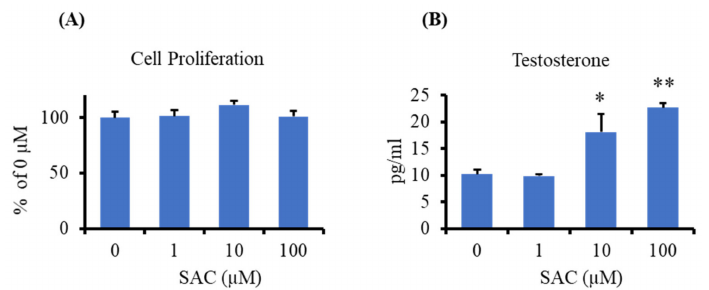
Figure 4. SAC enhances testosterone production in I-10 cells. ( A ) Cells at a density of 3.6 × 10 4 cells/well were incubated in 96-well plates for 24 h with different concentrations of SAC (0, 1, 10, and 100 µ M). Cell proliferation was determined by the water-soluble tetrazolium salts-1 (WST-1) assay. Data are presented as the mean ± SE ( n = 4–5). Data were analyzed by one-way ANOVA. ( B ) Cells at a density of 6 × 10 4 cells/well were incubated in 12-well plates with SAC for 24 h. Testosterone was measured from the medium by the EIA method. Data are presented as the mean ± SE ( n = 3). Data were analyzed by Dunnett’s test. * p < 0.05 and ** p < 0.01 vs. 0 µ M.